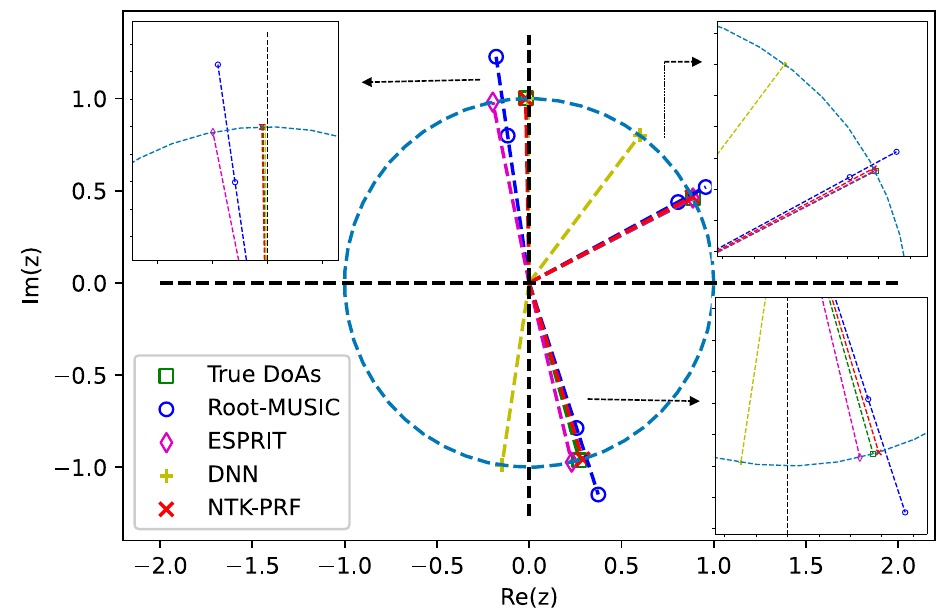
Figure 3. Three DoAs estimation in the presence of mutual coupling. Training data is at every 0.9° , and three DoAs are 30.09° , 74.95° and 134.95° respectively.